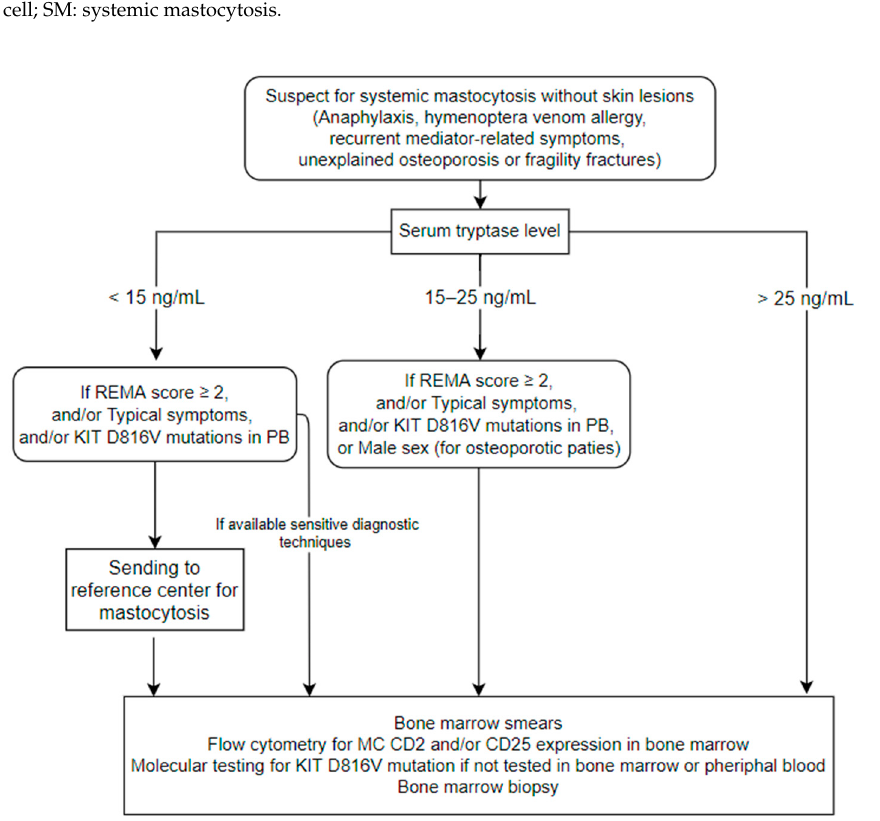
Table 2. REMA score. A score ≥ 2 is an efficient cutoff value to predict both MC clonality and SM. VARIABLE SCORE Male +1 GENDER Female − 1 Absence of hives, pruritus and angioedema +1 CLINICAL SYMPTOMS Hives, pruritus and angioedema − 2 Presyncope and/or syncope +3 <15 ng/mL − 1 S-BASAL TRYPTASE >25 ng/mL +1 Modified from Alvarez-Twose I et al. [25]. Abbreviations: REMA: Spanish Network on Mastocytosis; MC: mast cell; SM: systemic mastocytosis.